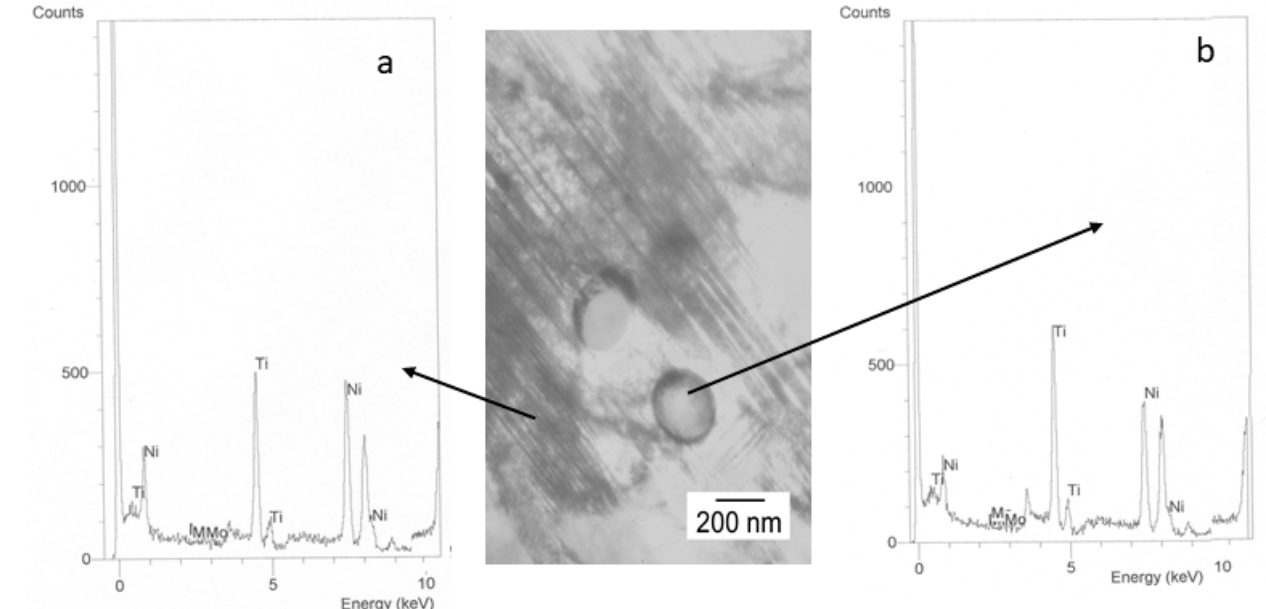
Figure 6. Ti 2 Ni precipitates in martensite observed by TEM. Zone axis [110]. EDS for matrix ( a ) and precipitates ( b ).